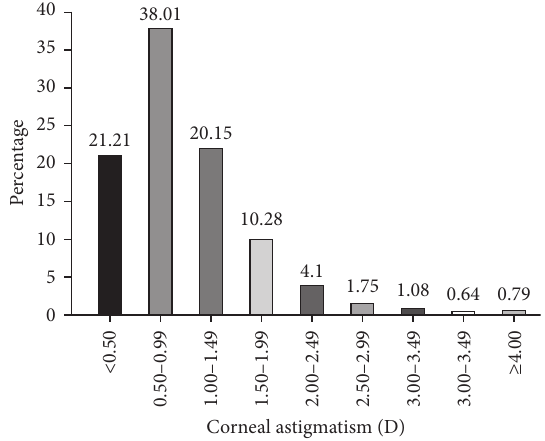
Figure 1: Distribution of corneal astigmatism (D).